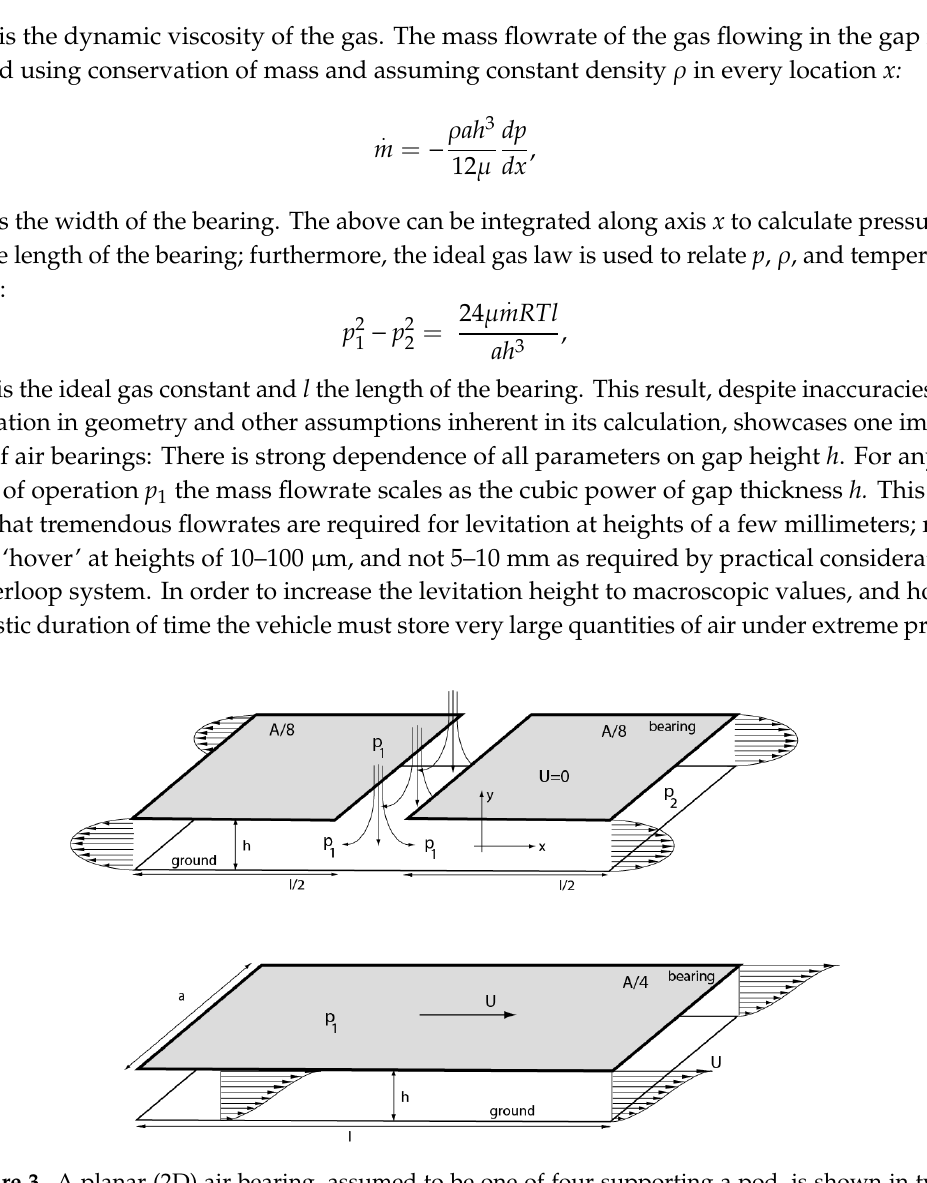
Figure 3. A planar (2D) air bearing, assumed to be one of four supporting a pod, is shown in two different configurations; top: an aerostatic bearing hovering at low/zero speed, with a Poiseulle gas flow established in the two halves of the bearing; bottom: an aerodynamic bearing at high speed, with a compressible Couette gas flow established in the gap between bearing and ground. For simplicity the slot for the air inlet is omitted from the bottom drawing. In both drawings the shaded area denotes the external surface of the bearing near the ground. This is a solid surface in the case of rigid bearings and a semi-flexible surface in the case of air-casters. The pressure inside the bearing in each case is assumed constant ( p 1 ) while the bottom surface is kept planar and parallel to the ground track, even in the case of a flexible air-caster. (cid:12) (cid:13)